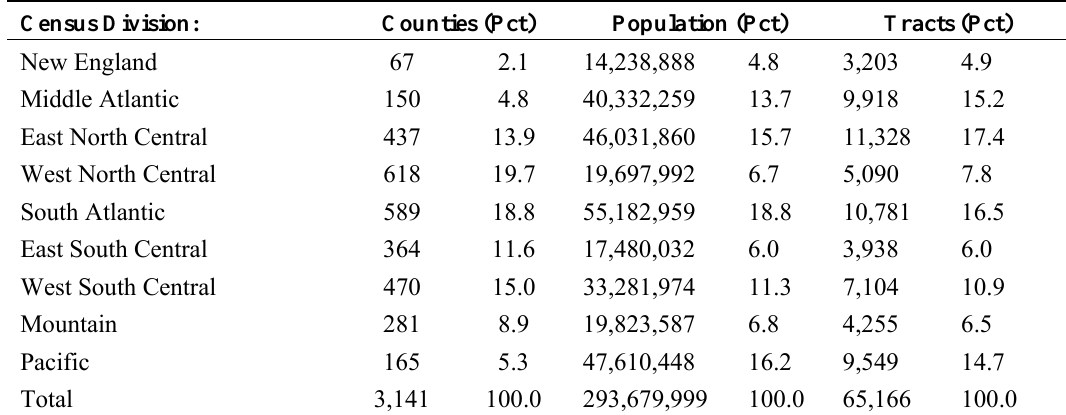
Table A1. Study Population: U.S. Census Tracts and Counties (2000).